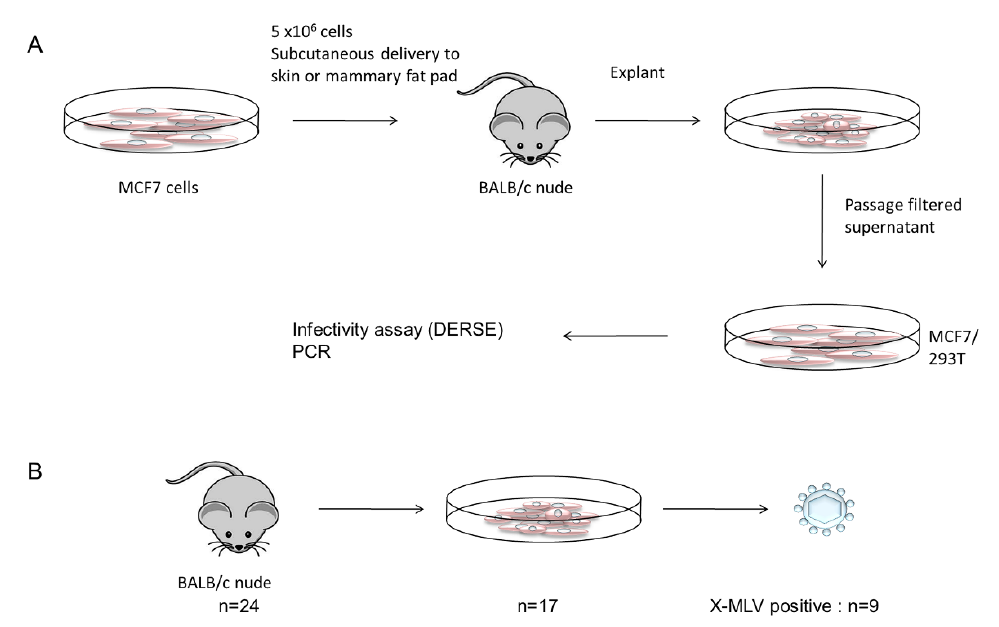
Figure 1. Experimental design and key findings from xenografting of MCF7 cells in BALB/c mice. In an initial experiment ( A ) cells were inoculated subcutaneously and thereafter by the intra-mammary route. Growing tumors were explanted and culture supernatant was filtered to remove contaminating cells before infection of fresh MCF7 or 293T cells. After passage to allow virus spread (2 weeks) cultures were assayed for the presence of replicating virus using the DERSE assay [21] with confirmation by virus-specific PCR. This process was repeated in further experiments involving intra-mammary inoculation. ( B ) summarises the cumulative results. In total, 24 xenografts gave rise to 17 growing tumors and viable explants, of which nine were positive for replicating